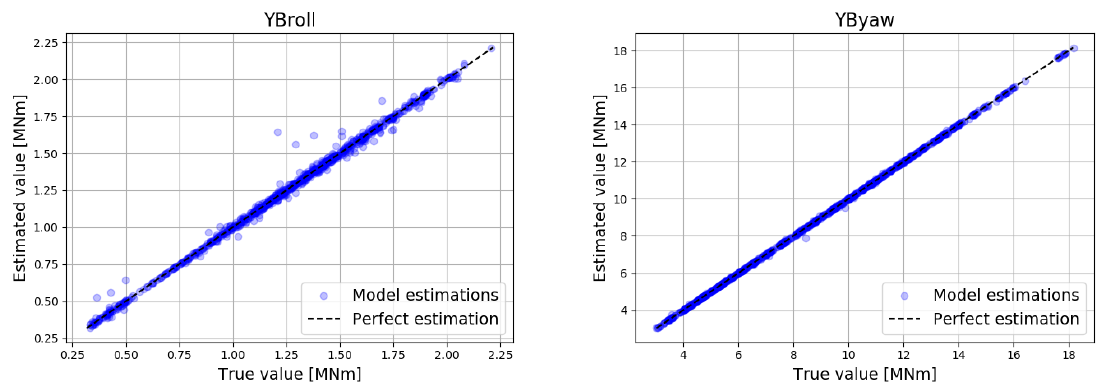
Figure 6. YBroll and YByaw estimated and observed values for GPR